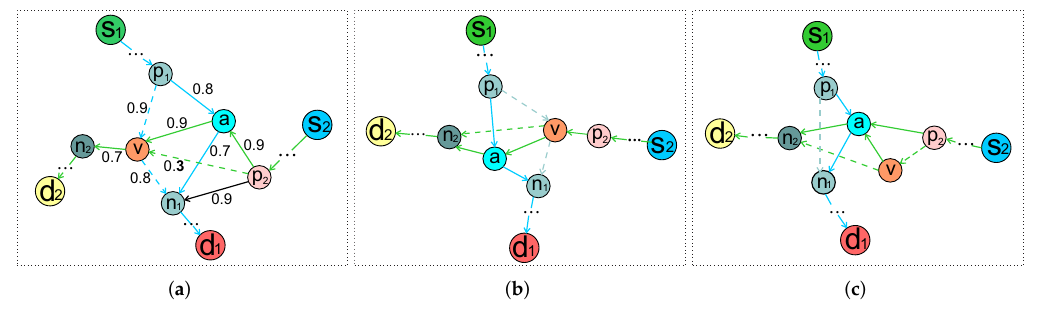
Figure 4. Three main cases dealt with by the algorithm. ( a ) Alternative local path strategy under poor quality of input link. ( b ) Alternative local path strategy under poor quality of output link. ( c ) Alternative local path strategy under current node without coding